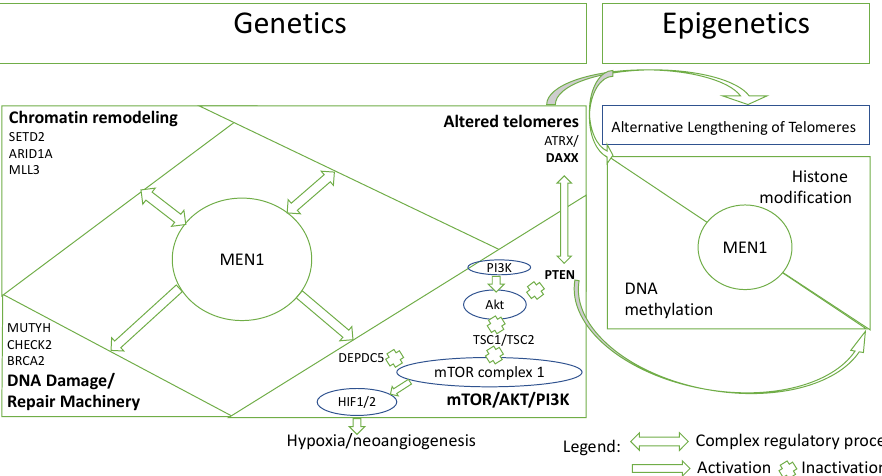
Figure 1. Simplified overview of altered components of main pathways in pancreatic neuroendocrine tumors and their interaction with epigenetic changes mentioned in this review 1 . 1 Please note that this is a simplified figure based on [1,11,56].